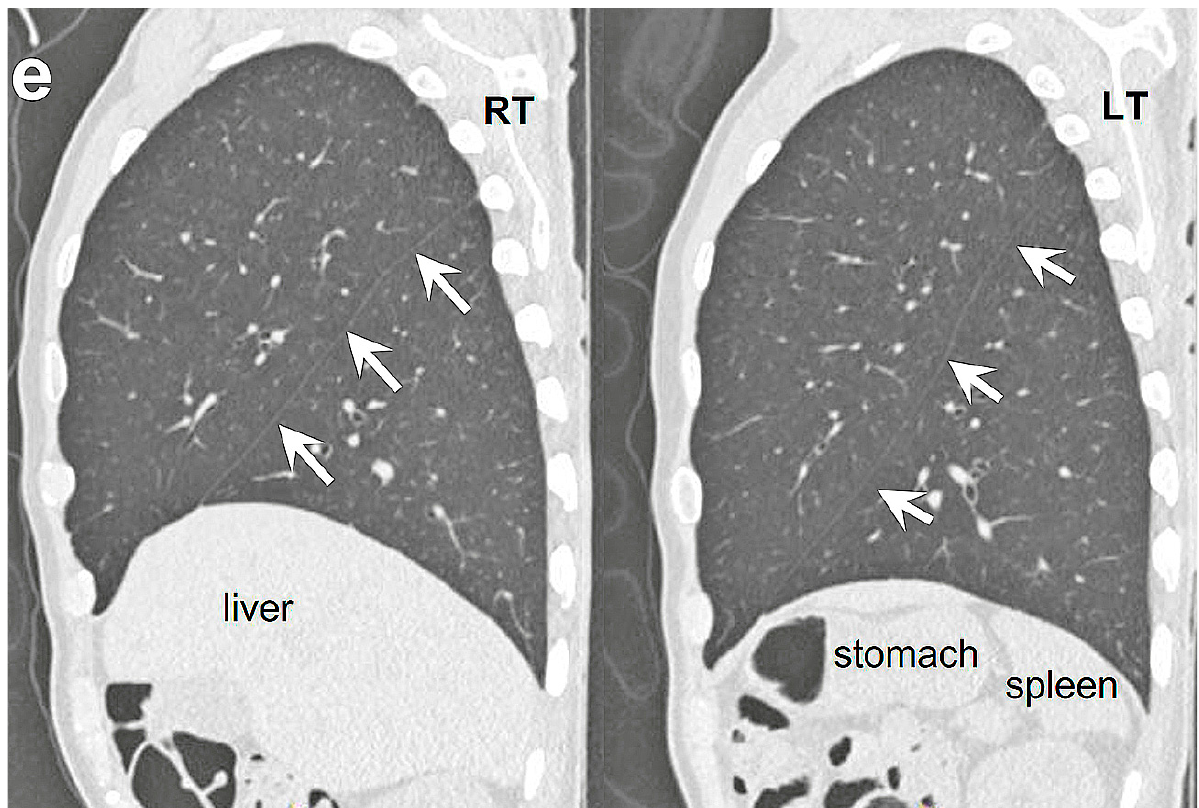
Figure 1. A 74 year old man with tracheal bronchus and left bronchial isomerism. ( a ) An axial chest CT image with lung window setting showing an aberrant bronchus (tracheal bronchus, arrow) arising from the right main bronchus at the level of carina. ( b ) A coronal, reformatted chest CT image with lung window setting showing symmetrical long both main bronchi resembling the left bronchus morphologically. Right upper lobe bronchus (RUL) is located below the point where the pulmonary artery (asterisk) crosses the main bronchus as on the left (hyparterial). Note tracheal bronchus directing towards the right upper lobe. ( c ) Reconstructed, 3D CT image of the tracheobronchial tree revealing both upper lobe bronchi in the same position. Similar to lingular division (arrow) of the left upper lobe bronchus, the right middle lobe bronchus (RML, arrow) arises with the right upper lobe bronchus. Displaced apical segmental bronchus (B1, thin arrow) arises from tracheal bronchus. Posterior and anterior segmental bronchi (B2 and B3) arise from right upper lobe bronchus. ( d ) Superimposed 3D CT image of the tracheobronchial tree and pulmonary arteries (asterisks) showing that both upper lobe bronchi (arrows) are hyparterial. ( e ) Sagittal reformatted CT images with lung window setting showing bilobed left and right lungs (arrows indicate both major fissures). There is no minor fissure in the right lung.